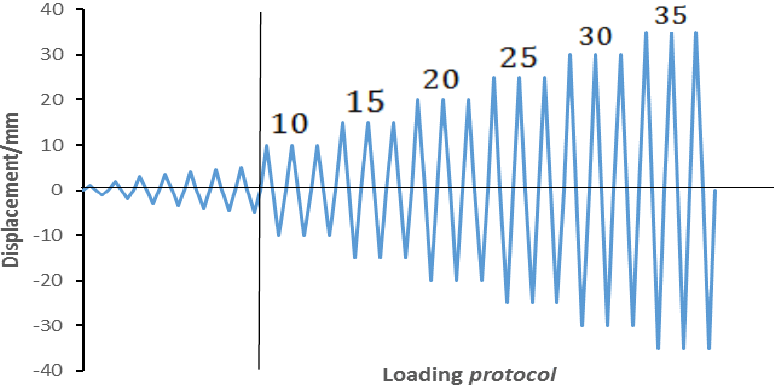
Figure 4. Loading protocol.